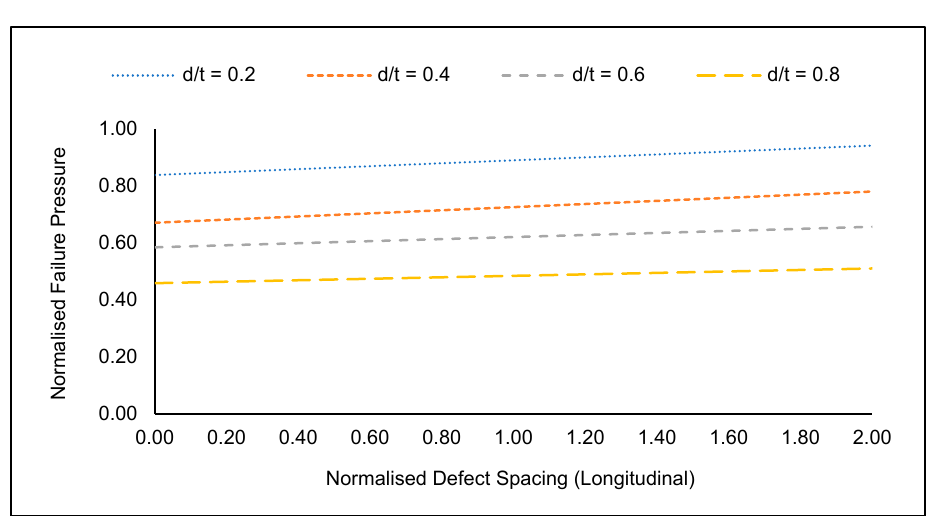
Figure 11. Normalised failure pressures of corroded (defect at the intrados) API 5L X80 pipe elbow with a normalised defect spacing (longitudinal) of 0.5 subjected to a normalised axial compressive stress of 0.2.